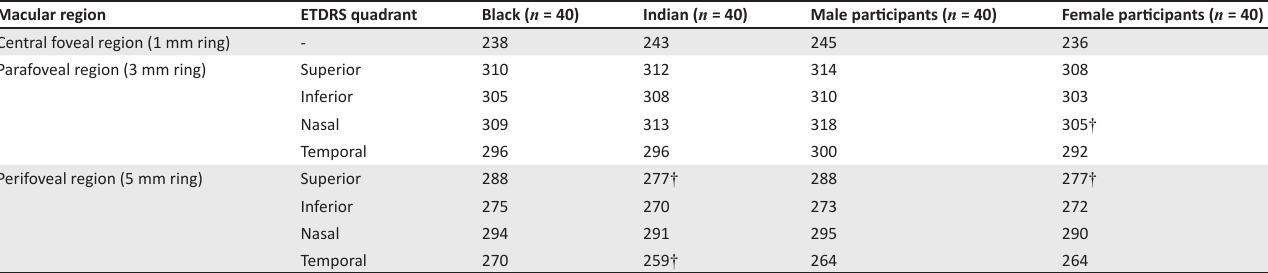
TABLE 2: Retinal thickness ( µ m) in each Early Treatment Diabetic Retinopathy Study segment by race and gender indicated with means. Macular region ETDRS